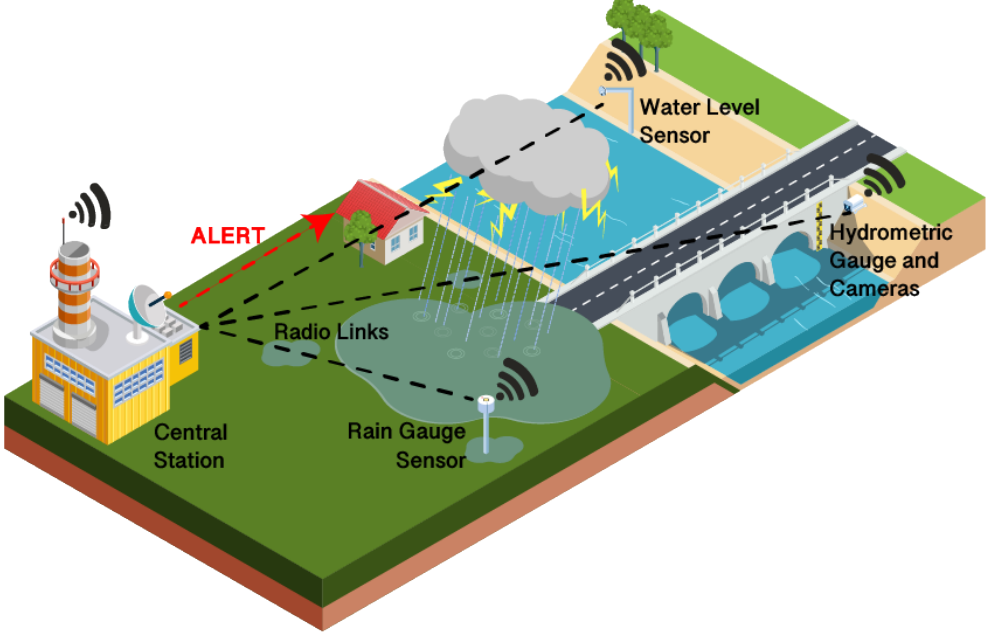
Figure 2. Example implementation of a Flood Early Warning System based on the